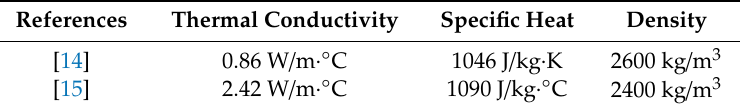
Figure 8. Comparisons between numerical simulations and laboratory tests. Table 3. Physical properties of